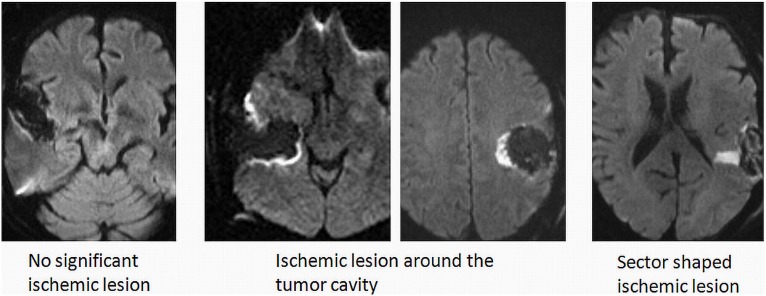
Example of the different main categories of ischemic lesions used in this study.